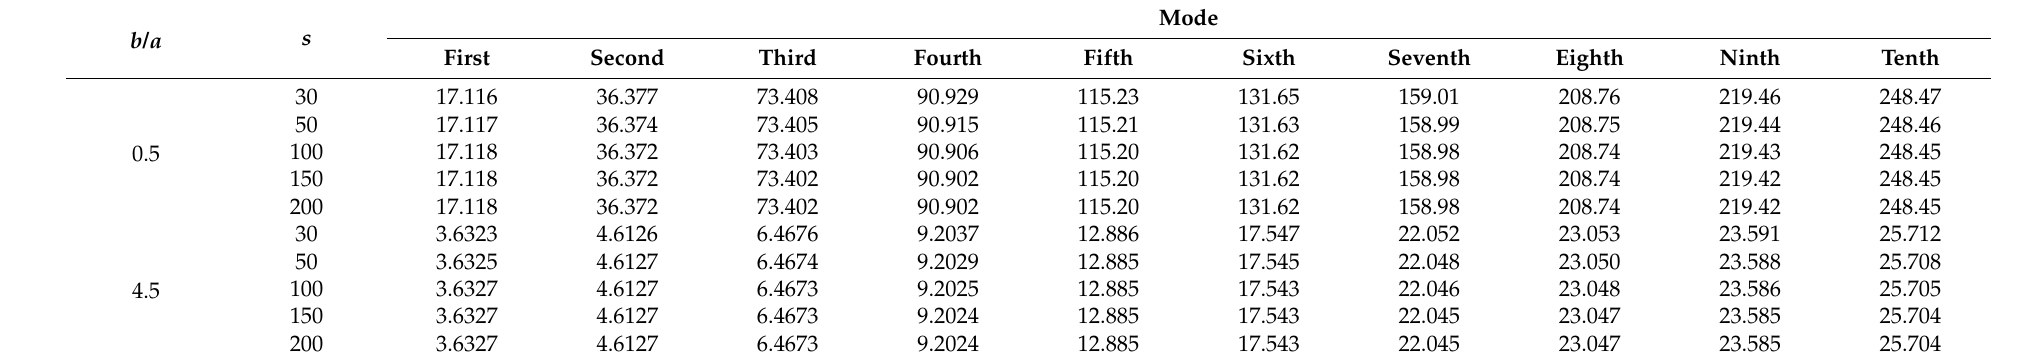
Table 7. Convergence of the dimensionless frequency parameter φ for the CCFF plates with aspect ratio χ equaling 0.5 and 4.5,